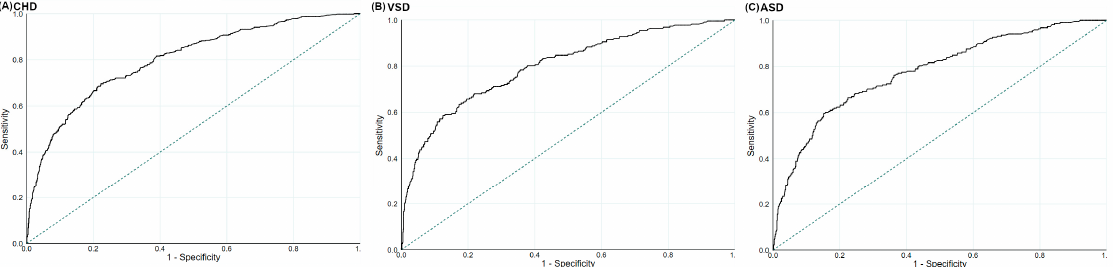
Figure 2. The ROC for the Global Diet Quality Score during pregnancy in the prediction of (A) total congenital heart defects, (B) ventricular septal defects, and (C) atrial septal defects. ASD, atrial septal defects; CHD, congenital heart defects; ROC, receiver operating characteristic curves; VSD, ventricular septal defects. The dotted line refers to the reference line, resulting from random selection.